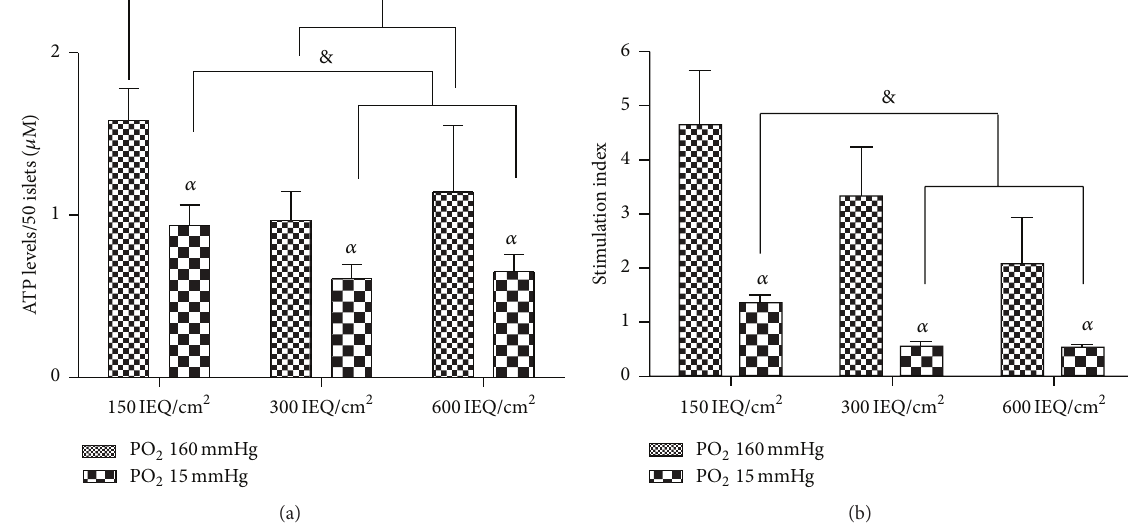
Figure 3: Islet functionality. (a) ATP levels were measured after 24 hours of culture at the 150, 300, and 600IEQ/cm 2 under normoxic (PO 2 160mmHg) and hypoxic (PO 2 15mmHg) conditions. (b) Insulin response to glucose stimulation was measured after 24 hours in culture using a stimulation index. Each density (150, 300, and 600 IEQ/cm 2 ) was evaluated under both normoxic (PO 2 160 mmHg) and hypoxic (PO 2 15 mmHg) conditions. 𝛼 𝑝 < 0.05 compared to the control, # 𝑝 < 0.05 compared to 150IEQ/cm 2 under normoxia, and & 𝑝 < 0.05 compared to 150 IEQ/cm 2 under